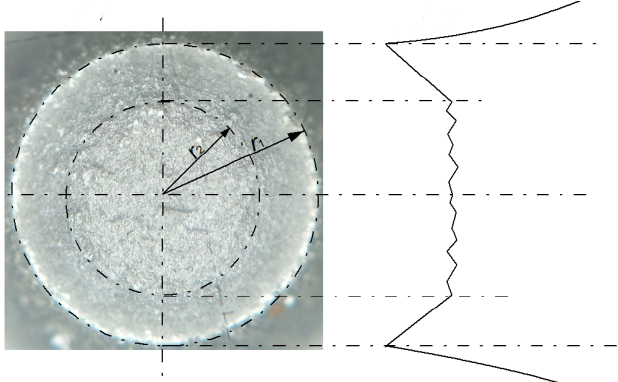
Figure 12. A cup ‐ and ‐ cone failure on a cylindrical, tensile specimen: view of break surface with Figure 12. A cup-and-cone failure on a cylindrical, tensile specimen: view of break surface with scheme of the break plane profile (for S355 steel) [110]. scheme of the break plane profile (for S355 steel)